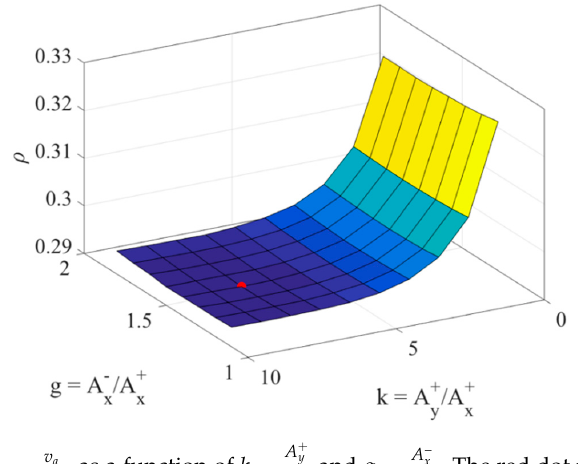
Figure 5. Values of ρ = v a solution of ρ = 0.294.